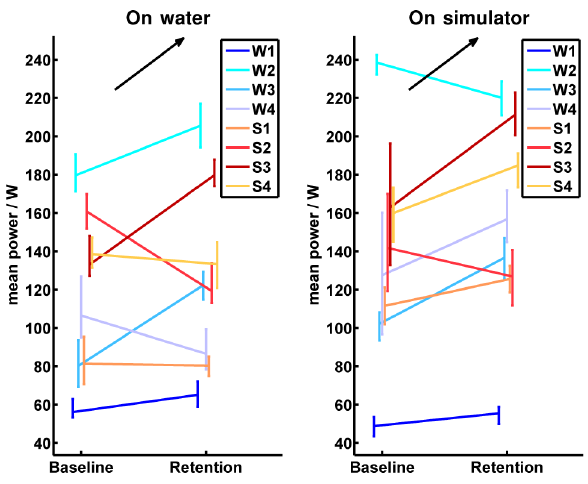
Figure 14. Absolute values of the mean power. The left half image shows the development of all participants from baseline to retention tests on water, while the right half image illustrates the baseline and retention measurements on the simulator. Participants of the on-water group are indicated by bluish colors and abbreviated by W 1 to W 4 in the legend. Participants of the simulator group are indicated by reddish colors and abbreviated by S 1 to S 4 in the legend. The vertical bars in the baseline and retention tests cover all values performed by the corresponding participant. The measured values in the baseline and the retention tests are connected in the mean values for each participant. The black arrow indicates the direction of the desired development from baseline to retention in the corresponding test environment.